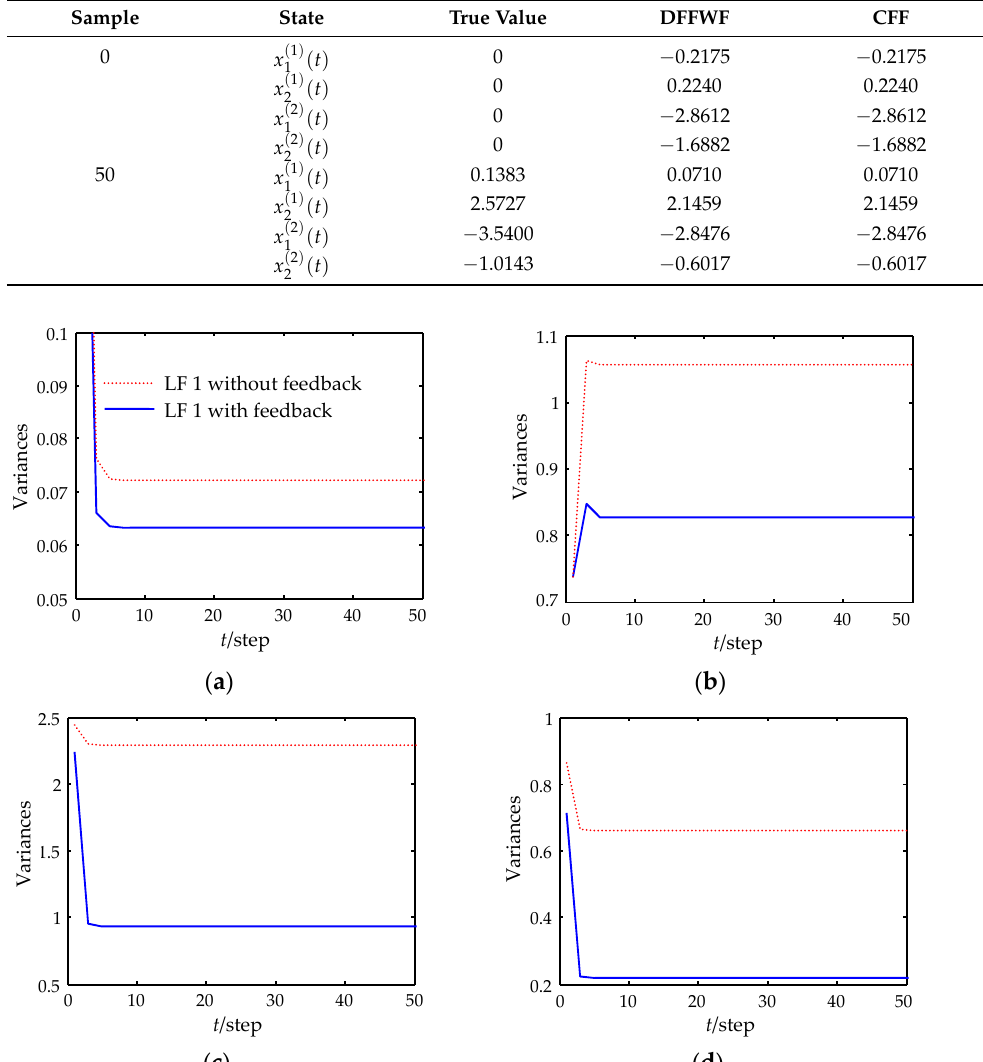
Table 1. True values and filters of SFF and CFF.